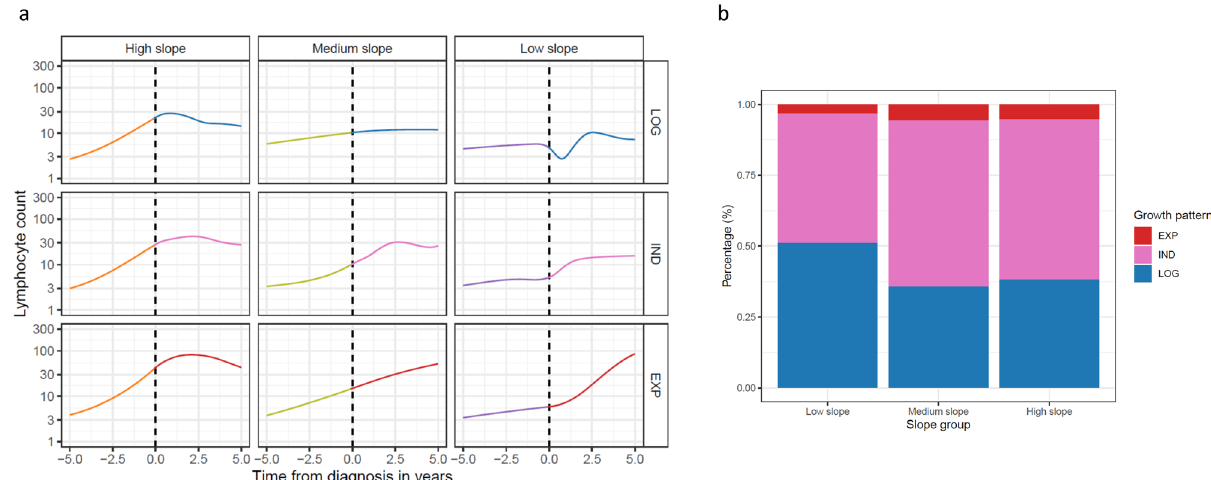
Fig. 4 Patterns and associations for the growth and slope groups. a Smoothed trajectory of the development of lymphocyte count before and after diagnosis in the three slope groups and the three growth patterns. b Distribution of the growth patterns between the lymphocyte slope groups. LOG logistic, IND indeterminate, EXP exponential-like.